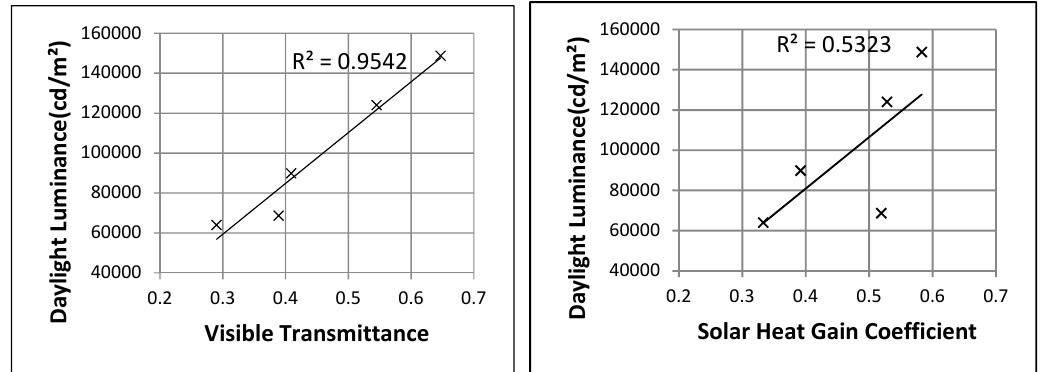
Figure 10. Correlations between visible light transmittance ( left ) and SHGC ( right ) and annual average daylight luminance.